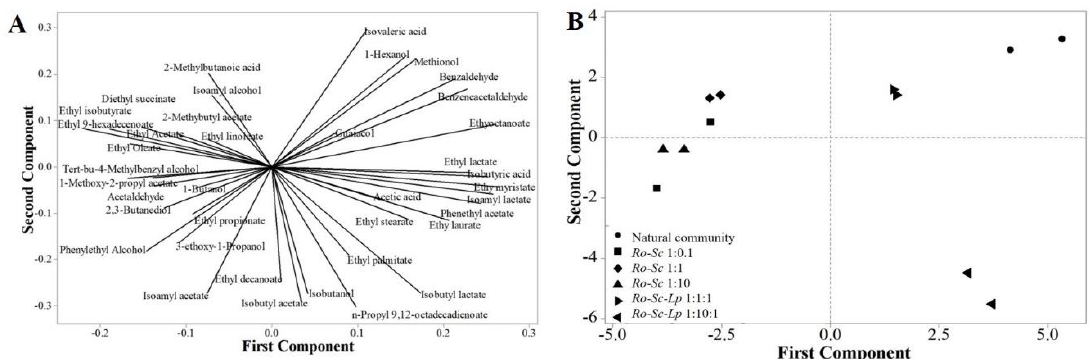
Figure 2. PCA) plot displaying the different aromatic profiles of rice wine by natural and synthetic communities. ( A ) plot of line distribution of 39 volatile compounds. ( B ) PCA plot discriminating each sample. In all cases, R. oryzae was inoculated at an initial concentration of 10 6 spores/ml. For the cultures involving either S. cerevisiae or L. plantarum , their initial concentration is indicated by 0.1, 1, or 10, corresponding to 10 5 , 10 6 and 10 7 CFU/mL, respectively. The same symbols represent the samples from biological replications.